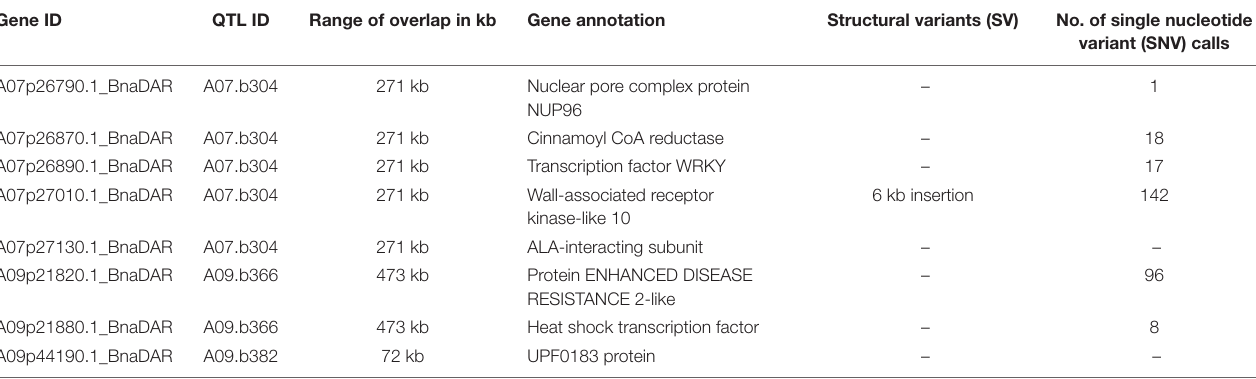
TABLE 2 | Genes within the L. maculans resistance QTL of the multiparental population overlapping with QTL of the diversity set based on GO terms that can be associated with plant resistance and numbers of genomic variants in the multiparental population. Gene ID QTL ID Range of overlap in kb Gene